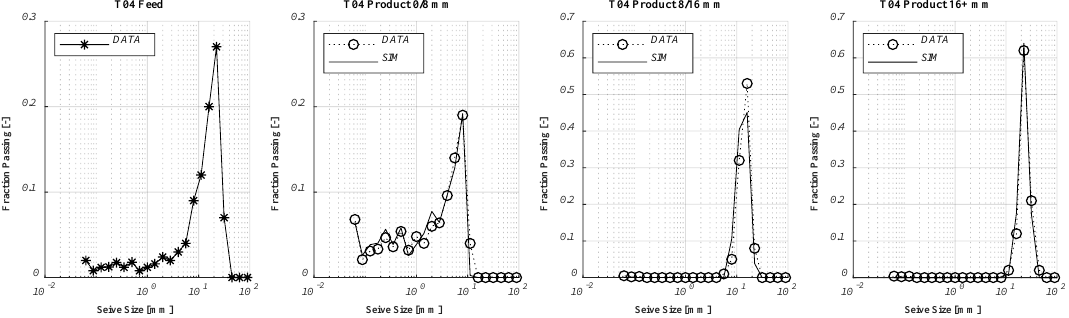
Figure A1. Screen 1 calibration results for T01 in the frequency domain.